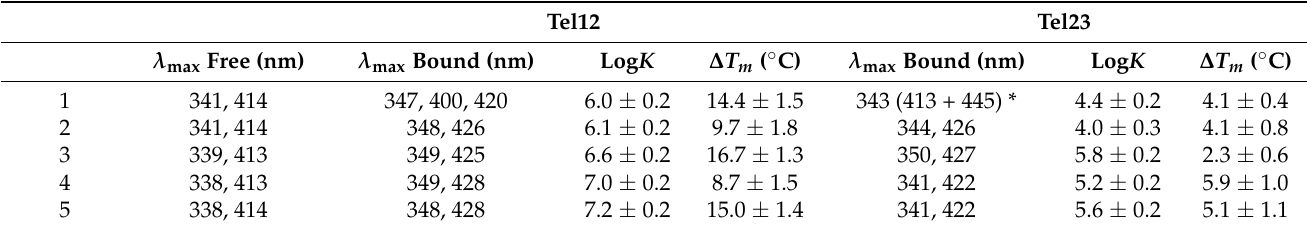
Table 1. Spectroscopic features, binding constants values and G-quadruplex melting temperature changes observed for the studied systems. KCl 0.1 M, NaCacodylate 2.5 mM, pH 7.0, 25 ◦ C.